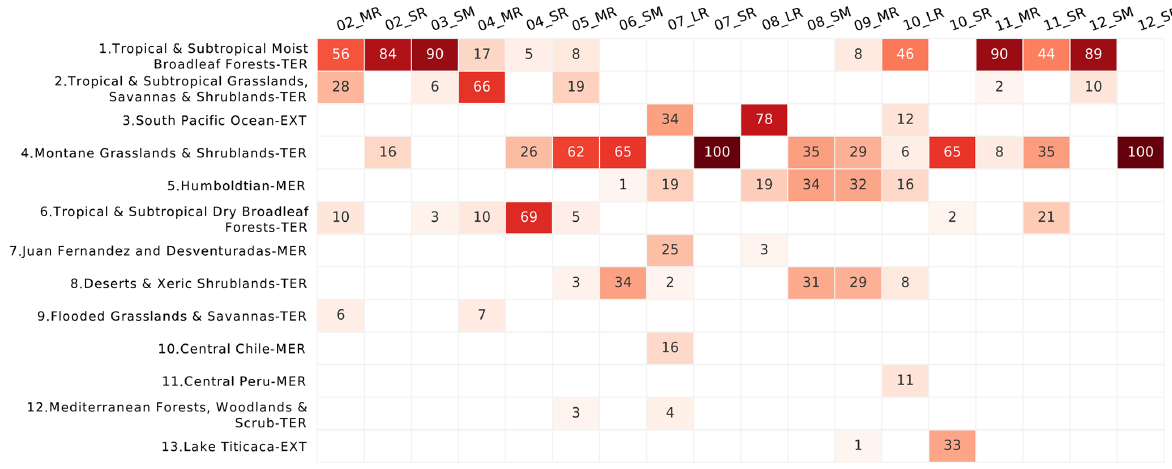
Figure 9. Heat map showing the biome and land cover characteristics associated with each of the 18 clusters. The percentage values indicate the percentage of air in each cluster that travels over each different biome. The darker the colour, the stronger the influence from the corresponding biome. For a description of the biomes see Sect. 4. Due to rounding errors and the use of integers, some columns add to 99 rather than 100.